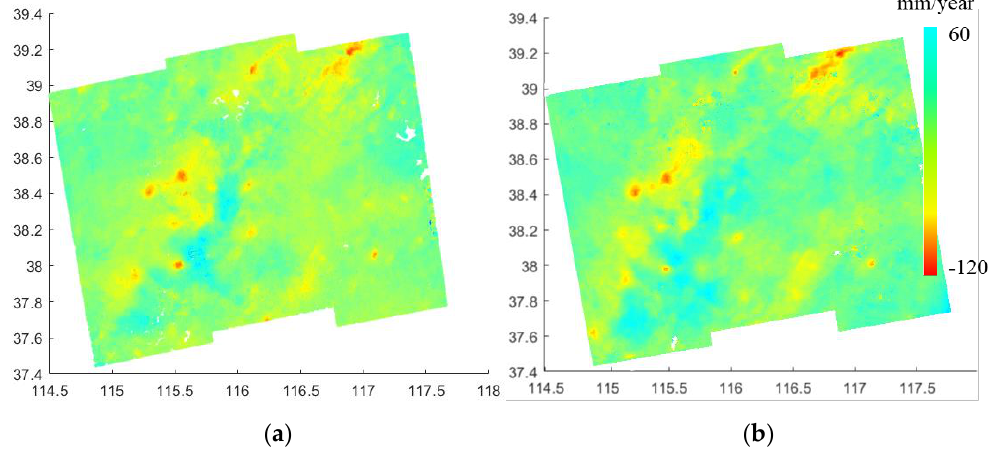
Figure 9. The deformation rate for Scene 142-2 estimated by P-CSInSAR ( a ) and GIANT ( b ).